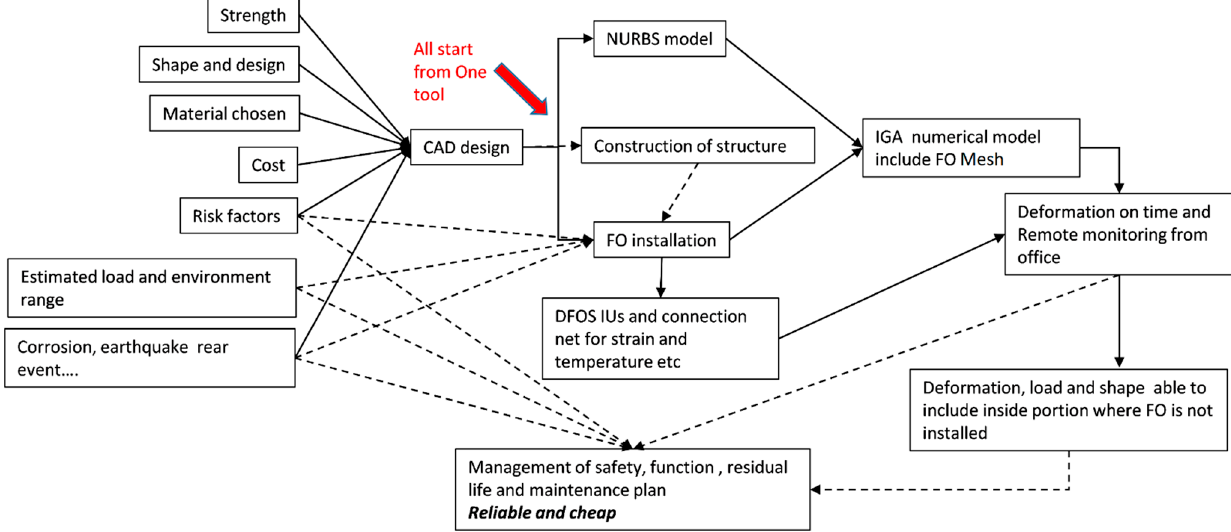
Figure 1. Block diagram of proposed method. The solid lines indicate direct actions, while the dashed lines illustrate the links of solutions to the factors of concern.